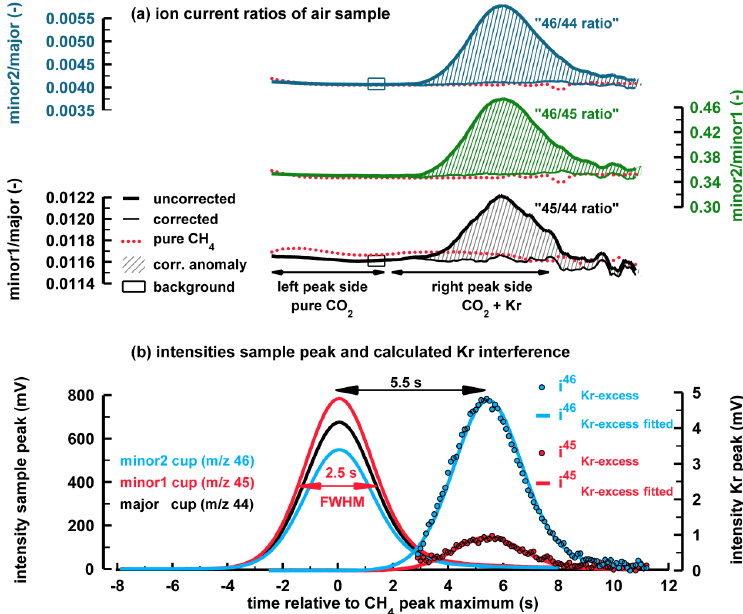
Fig. 11. Compilation showing the principle of the Kr correction for an air sample measured with the AWI system. (a) Ion current ratios in bold lines are the uncorrected ratios; the rectangle indicates the time interval that is used to determine the background to calculate the Kr interference shown in the panel below. The thin line and the hatched area show the ratio after the Kr correction, i.e. after the subtraction of the fitted Kr peak from the measured ion current. The red dotted line is the ratio of pure CH 4 without Kr interference. The “46/45 ratio” serves as an independent visual check of whether the correction was successful since the anomaly of this ratio is not used for the correction method. (b) Intensities for the three Faraday cups of the CH 4 sample (left axis). The interference calculated from the anomalies plotted in the ratios above (right axis) with the dots representing the calculated raw anomaly for m/z 45 and m/z 46, the lines are a fit to the respective data used for correction.